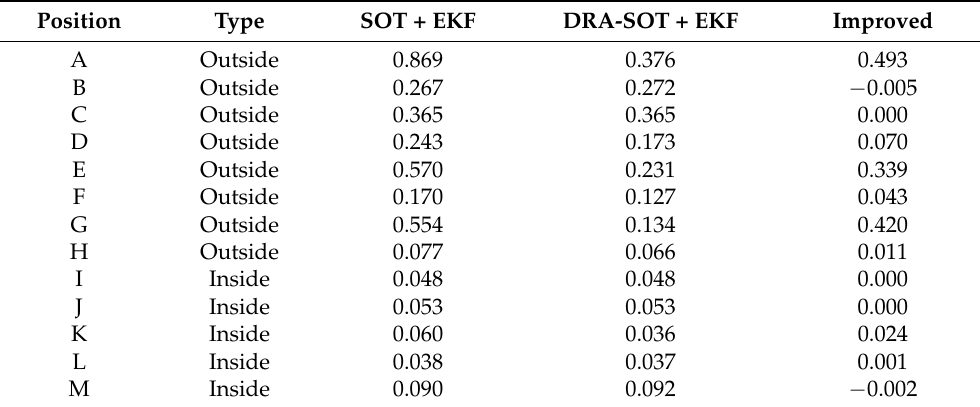
Table 1. The experimental positioning RMSEs.